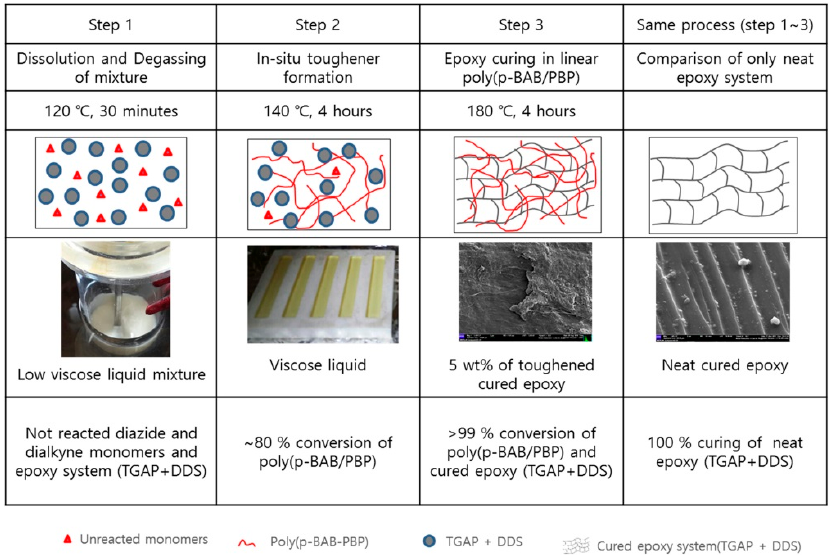
Figure 8. Schematics of the synthesis procedure and semi-IPN structure of neat epoxy and modified epoxy system having 5 wt % of poly(p-BAB/PBP). Reprinted with permission from ref. [60], Copyright